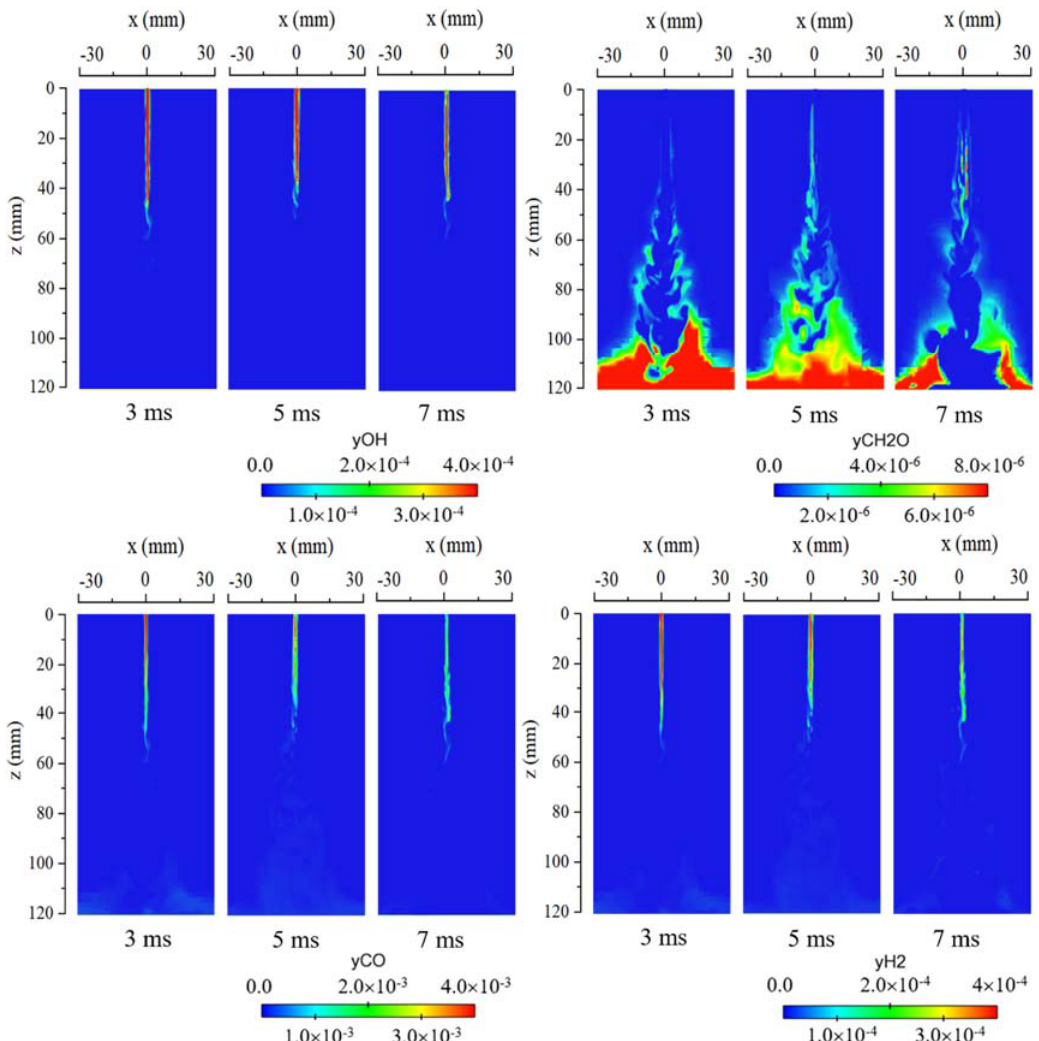
Figure 7. Distribution of major species in the jet for different spark timings at 3 ms after the hot jet appeared.